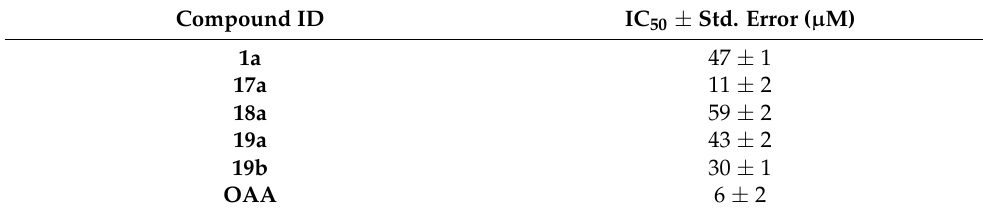
Figure 8. Products obtained from reactions under participation of the 1,2-dicarbonyl motif. Table 5. Modifications of the 1,2-dicarbonyl motif. 4-oxo-4 H -benzo[ d ]-[1,3]oxazine 17a obtained from 1a . Derivatives 19a and 19b obtained from the reaction of the anthranilic acid amide derivative 18a . Data fit with GRAPHPAD PRISM 5. Standard error of the fit given in µ M. IC 50 diagrams, including the fit and standard deviations of the individual experiments ( n = 3), are depicted in the Supplementary